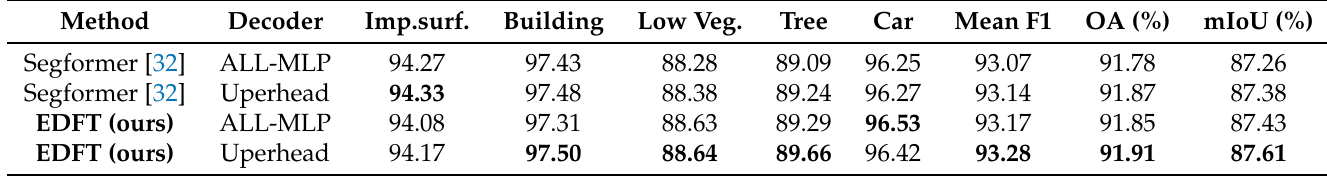
Table 3. Different decoder’s influence on the Potsdam test set. The values in bold are the best. Method Decoder